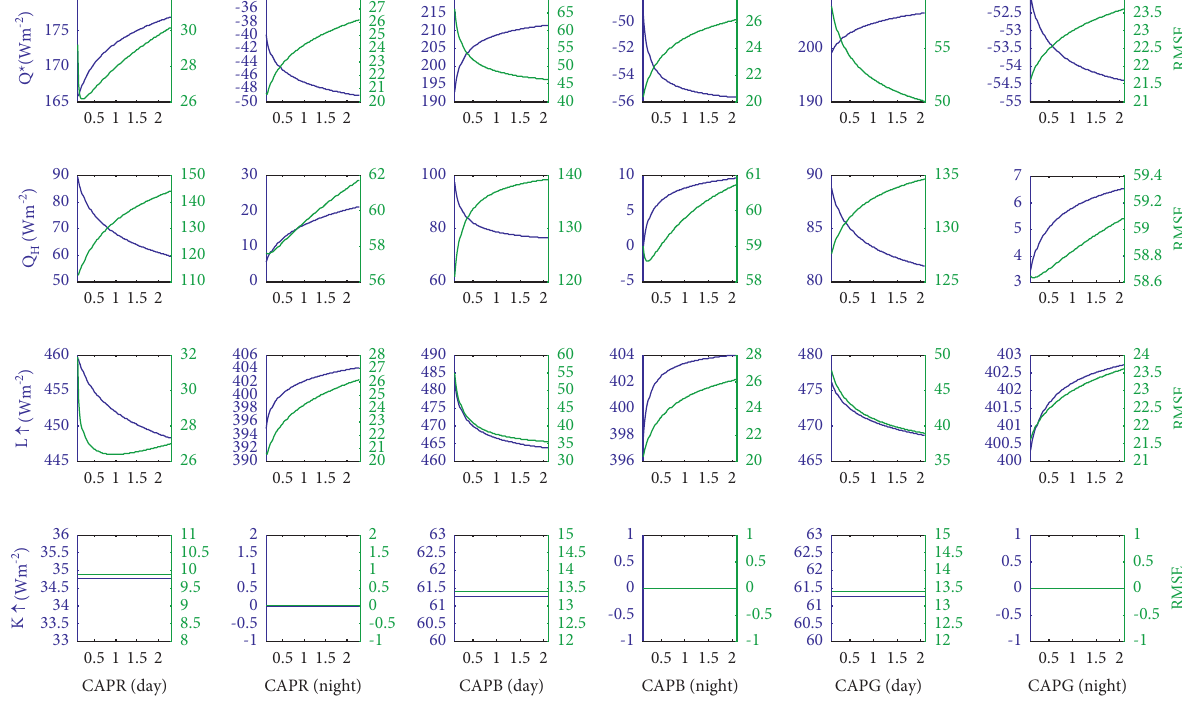
Figure 10: The same as Figure 7, but for capacity parameters.